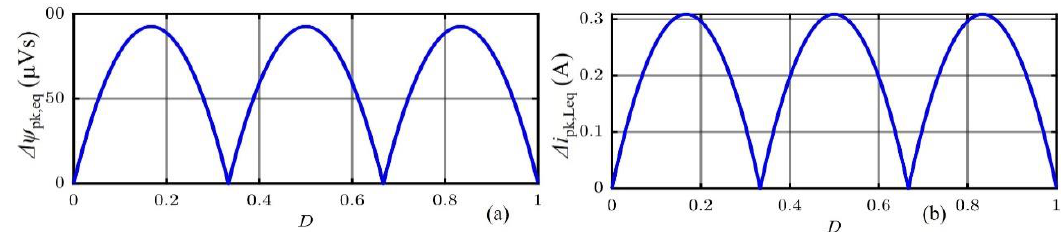
Figure 6. ( a ) Ripple of magnetic flux behavior for the three-leg IBPFC, ( b ) total ripple current behavior. Design parameters f sw = 60 kHz, v out = 400 V and L = 900 µ H.